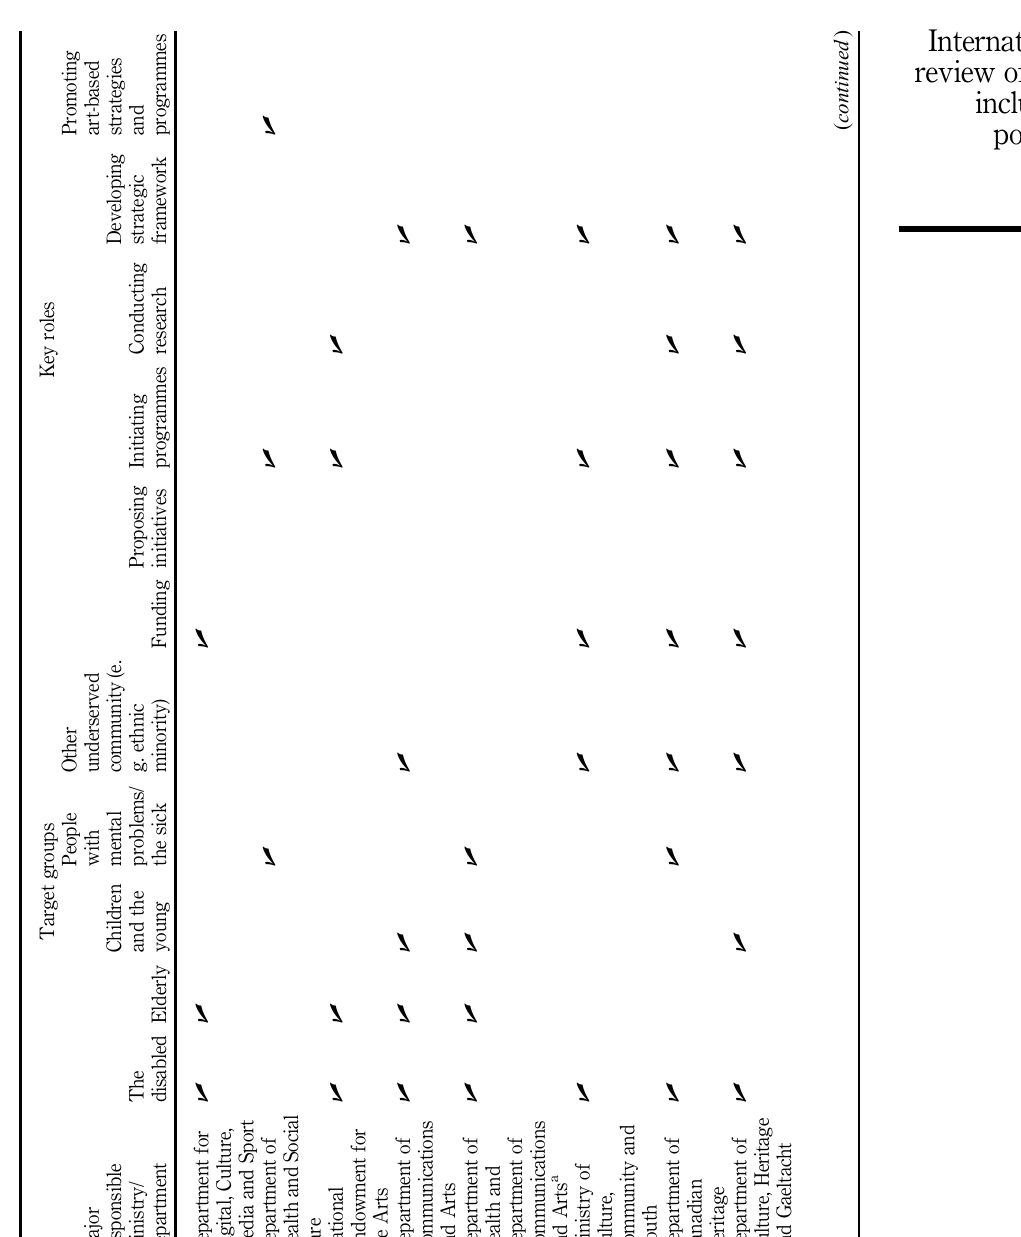
Table III. Overview of the policy options and target groups of